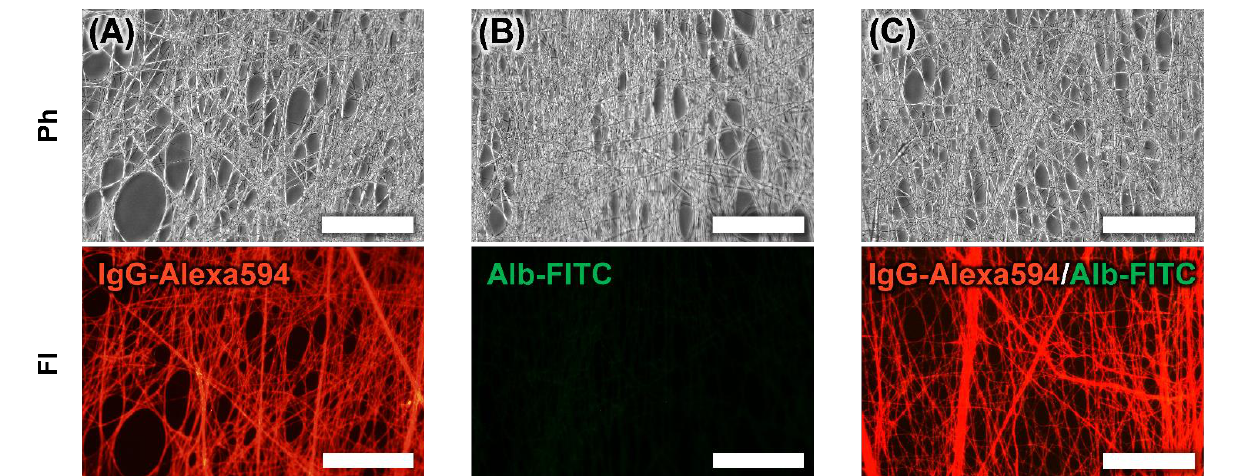
Figure 4. Fluorescent microscopy of core-shell CA/PVA + PA NF treated with ( A ) IgG-Alexa594 only (red), ( B ) albumin- FITC only (green), and ( C ) both of IgG-Alexa594 and Albumin-FITC (merged). Bar = 100 μm. Note that it was confirmed by preliminary experiments that the fluorescence intensity of the labeled albumin is equivalent to that of the labeled antibodies.